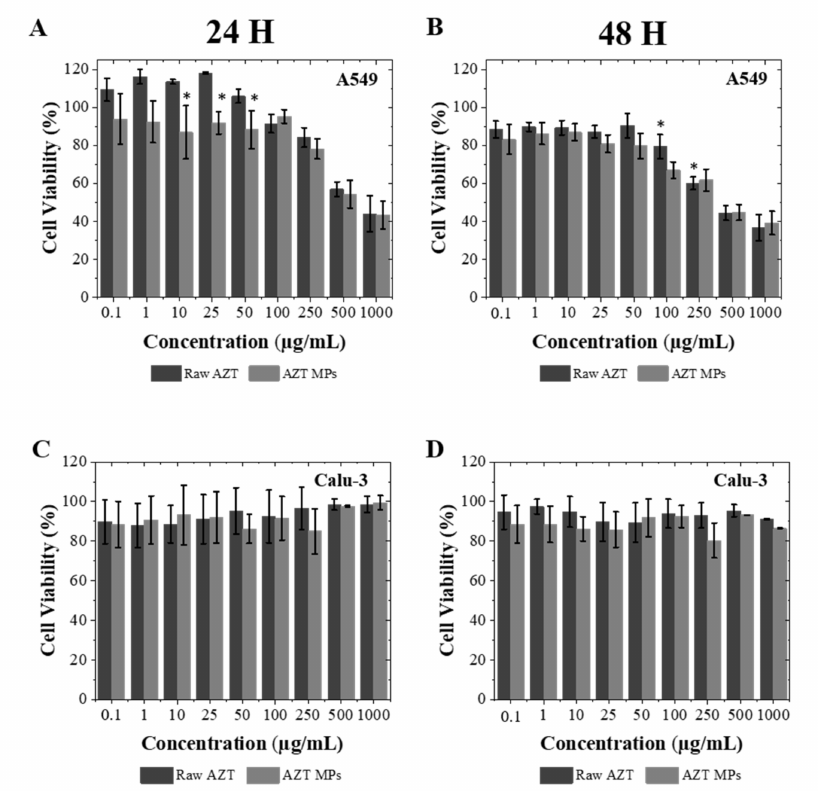
Figure 8. Cell viability measured by Alamar blue. A549 cell viability after ( A ) 24 h and ( B ) 48 h. Calu-3 cell viability after ( C ) 24 h and ( D ) 48 h. Both types of cells were exposed to increasing concentrations of microparticles in cell culture medium. Significant differences ( p < 0.05) between different samples were tested in relation to raw AZT (mean ± SD, n =